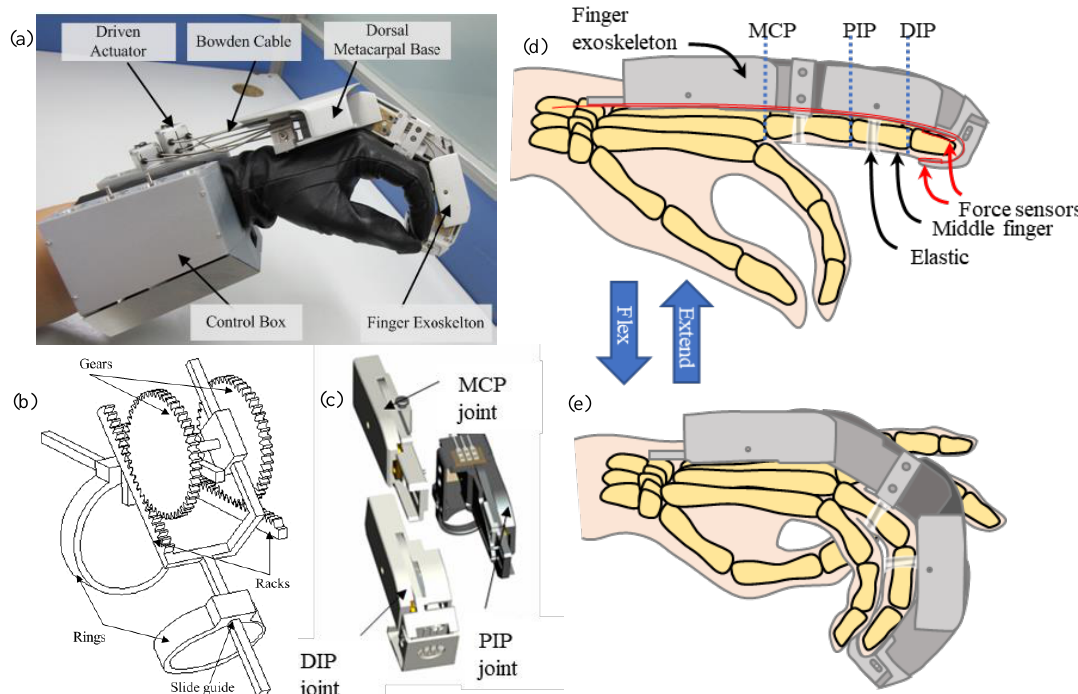
Figure 1. A hand exoskeleton system for rehabilitation: ( a ) overview; ( b ) the symmetric pinion and rack mechanism (SPRM) with the parallel mechanism; ( c ) the three joint modules; ( d ) the exoskeleton is attached to the extended middle finger by elastics and the exoskeleton is on the beginning state; ( e ) the middle finger with the exoskeleton flexes to the max range.